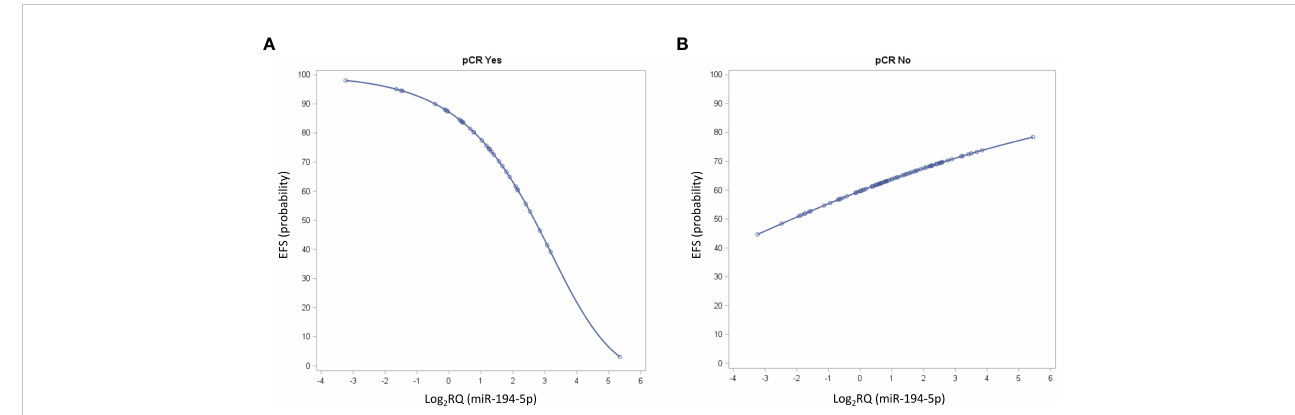
FIGURE 2 Seven-year Event Free Survival (EFS) probability curves for circulating miR-194-5p values according to pathological complete response (pCR) status. The curve depicts the predicted EFS probability of the circulating miR-194-5p expression levels considered on its continuous scale in patients (A) with pCR and (B) without pCR.